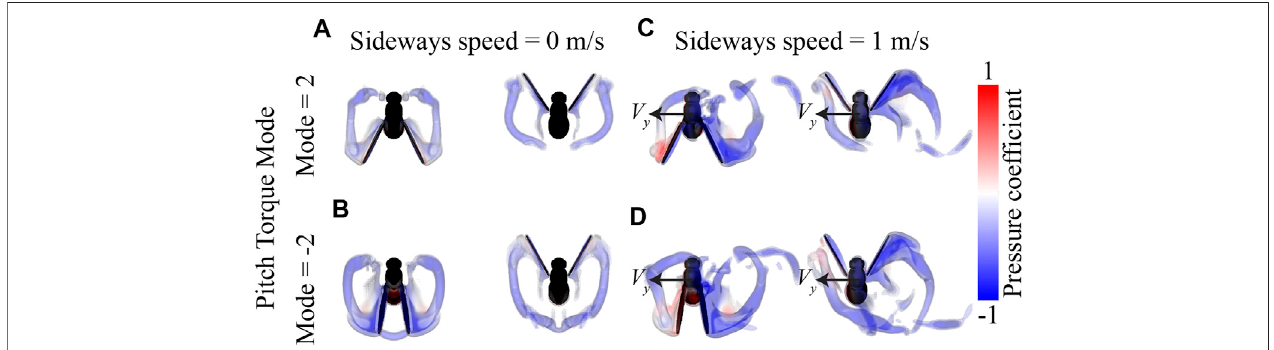
FIGURE 10 | Visualization ofthe air fl owaround fl ying fruit fl ies determinedusing CFD simulations. (A,B) Air fl owvisualizations around hovering fruit fl ies( V = 0 m/s), with the wingbeat pattern ofPitchTorque Mode = 2 and -2, respectively. (C,D) Air fl ow visualizations around fruit fl ies fl ying witha sideways speedof ( V = 1 m/s,and PitchTorque Modeof2and-2, respectively.Eachpanelshowsresultsforthestroke-reversalatdorsalandventralsides(leftand right,respectively).All fl iesareshownfrom above,and the air fl ow is visualized using iso-surfaces of constant vorticity (4,000 and 5,000 s − 1 ), color-coded with the air-pressure coef fi cient at the surfaces (see legend).